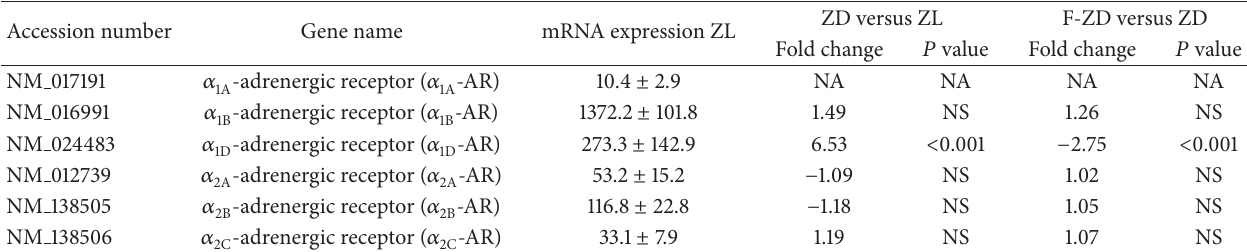
Table 1: Alpha-adrenergic receptor gene expression in the kidney cortex of Zucker lean (ZL), untreated Zucker diabetic fatty (ZD), and fenofibrate-treated diabetic fatty (F-ZD)